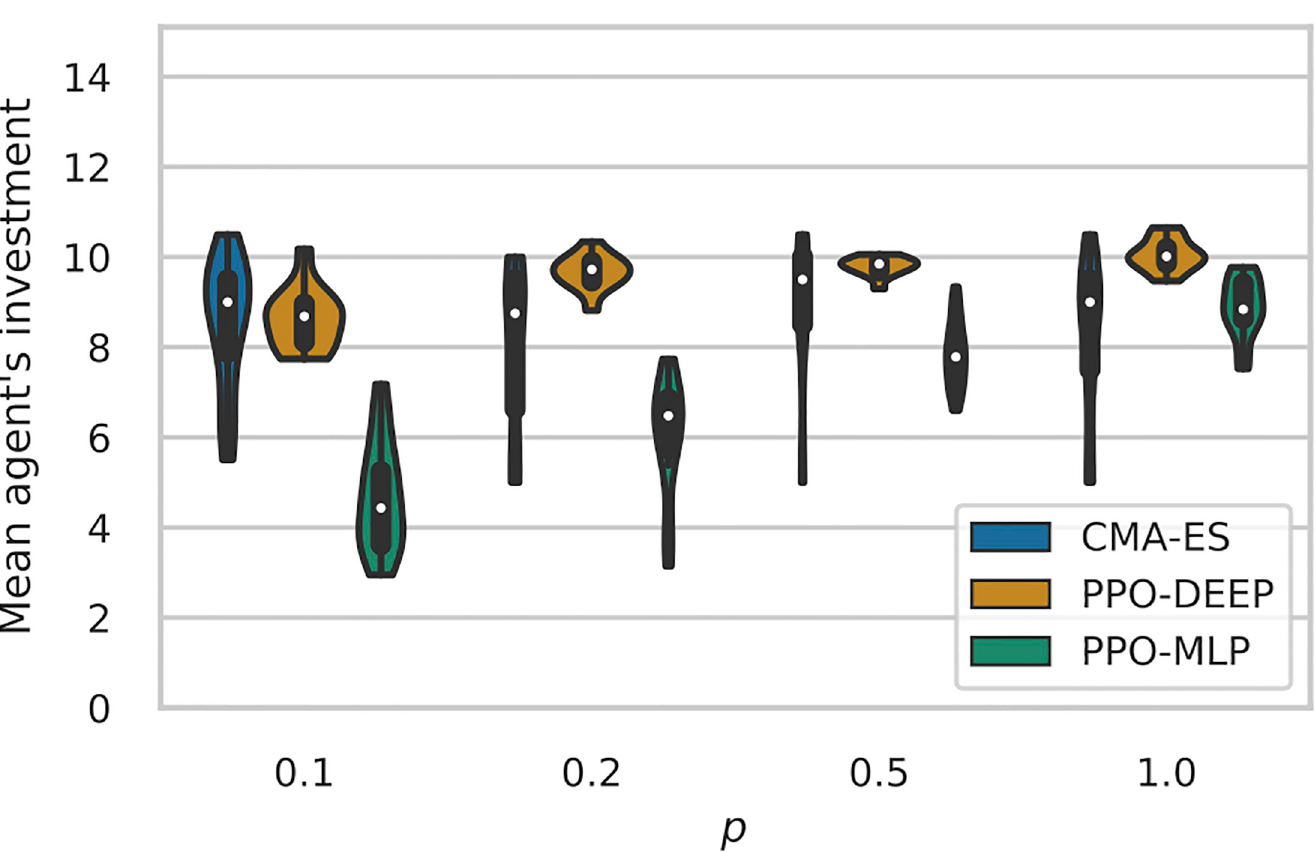
Fig 5. Investment value of the focal agent given by the Investment Module for the best learned policies with CMAES (blue), PPO-DEEP (orange) and PPO-MLP (green) algorithms, for each condition p . Each violin graph represents the results of the outcome of the 24 best policies for a given algorithm and condition after being re-evaluate for 1000 episodes without